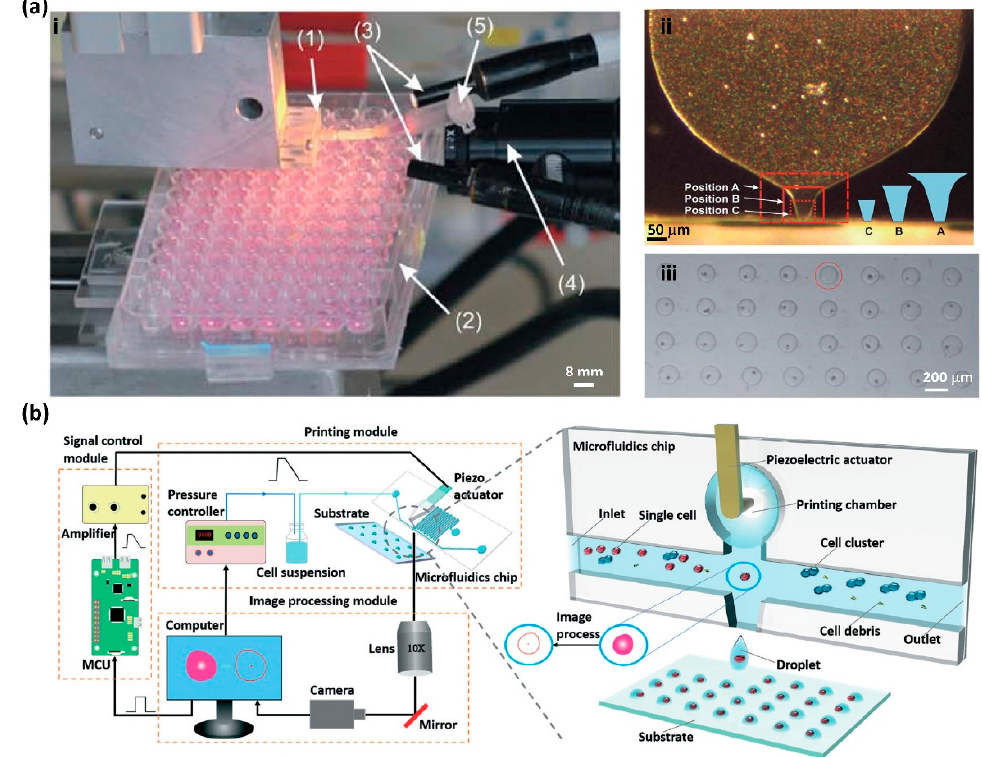
Figure 3. ( a-i ) The single-cell printer consists of a dispenser chip (1) mounted to an aluminum case with a piezo stack actuator, a substrate, or microplate (2) for single-cell printing, an illumination system (3), a CCD camera (4) for cell detection, and a reservoir (5) for cell suspension loading. ( a - ii ) The size of the ROI was determined by the volume of the printed droplet. ( a - iii ) A single HeLa cell array was printed on a substrate. Reproduced with permission from [40]. ( b ) Schematic illustration of the real-time cellular recognition-based single-cell printing system using the microfluidic dispenser chip and droplet generation. Reproduced with permission from [41].